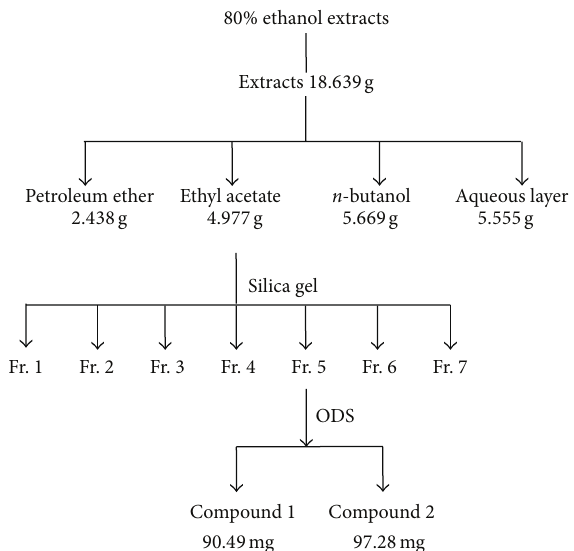
Figure 2: The process of extraction, isolation, and fractionation of bioactive compounds from CA6.